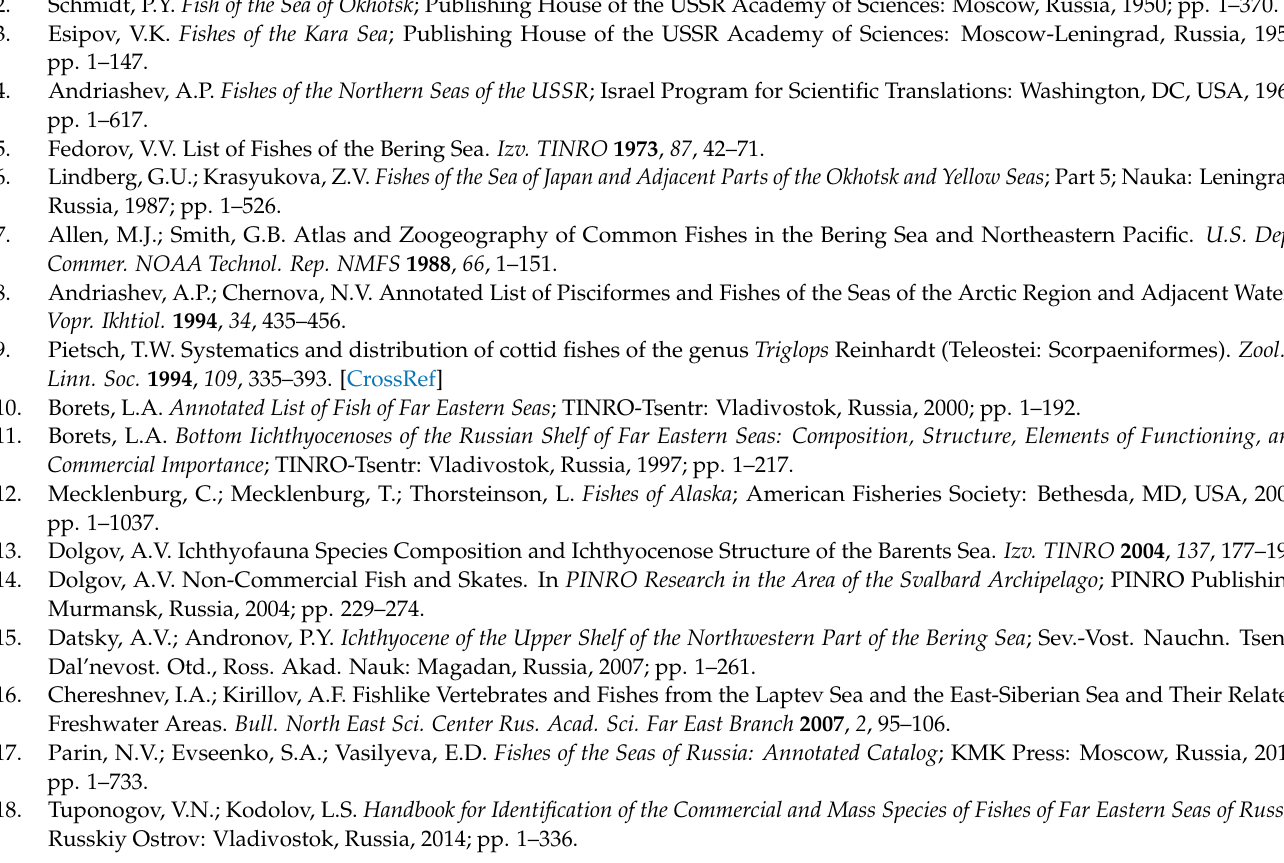
Table S3: Results of ANOSIM test for diet composition among various size groups of ribbed sculpin Triglops pingelii in the Kara Sea, September 2019 (permutation N = 999, α = 0.05, R = 0.088, p = 0.012). Values in bold are statistically